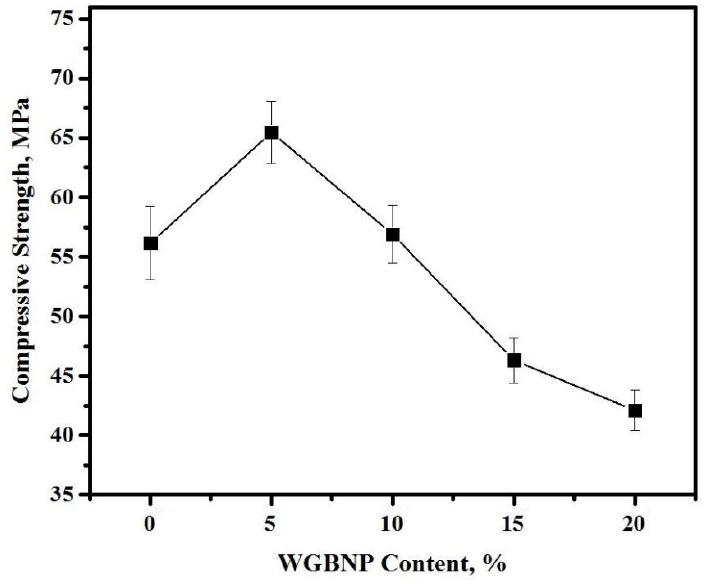
Figure 6. Effect of varying the BGWNP content on the compressive strength development of AAMs